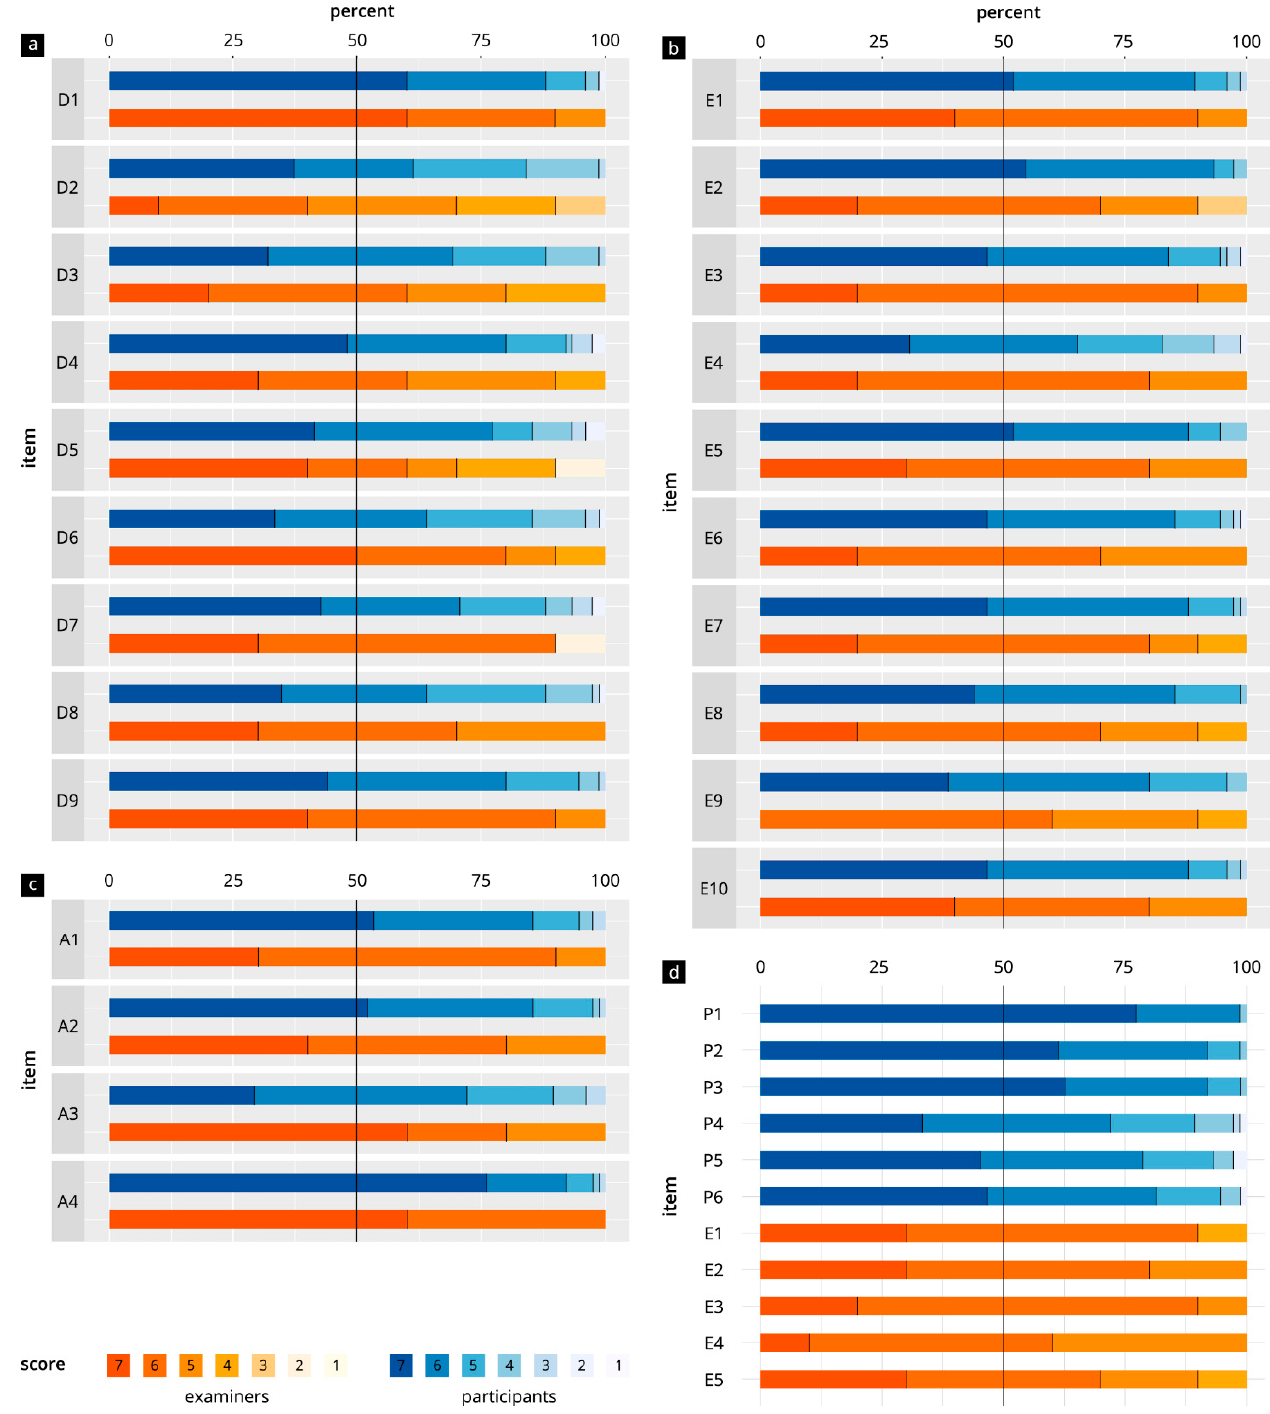
Figure 3. Comparison of items in direct observation of procedural skills (DOPS) tests in participants and examiners. ( a ) General aspects of the DOPS (D1–D9). ( b ) Test atmosphere (A1–A4). ( c ) Test tasks (T1–T10). ( d ) Specific items for the participants (P1–P6) and examiners (E1–E5).